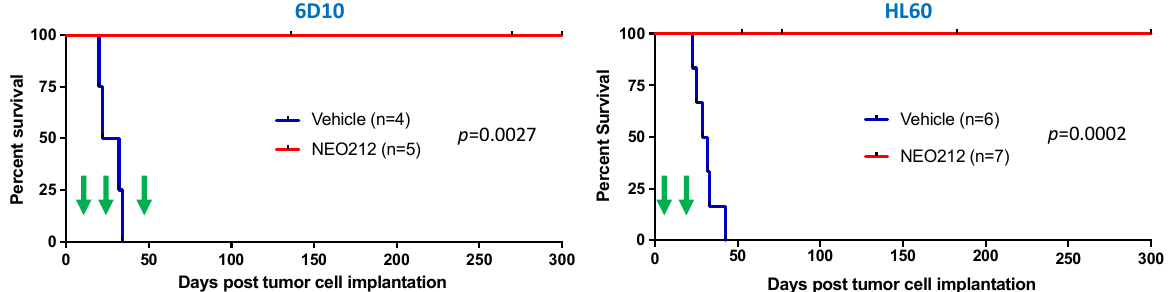
Figure 8. NEO212 exerts therapeutic activity in drug-resistant AML in vivo. AraC-resistant 6D10 cells ( left panel ) and TMZ-resistant HL60 cells ( right panel ) were implanted into immuno-deficient mice. Thereafter, animals were randomly separated into groups and subjected to vehicle or NEO212 treatment, as indicated by green arrows. The 6D10 model received three cycles of NEO212, starting on days 11, 25, and 48, respectively. The HL60 model received two cycles, starting on days 5 and 19, respectively. There were no further drug treatments beyond day 52 (6D10) or day 23 (HL60). In all cases, survival of animals was monitored and is presented as Kaplan–Meier plots. p -values shown represent statistical difference between NEO212-treated and vehicle-treated groups.